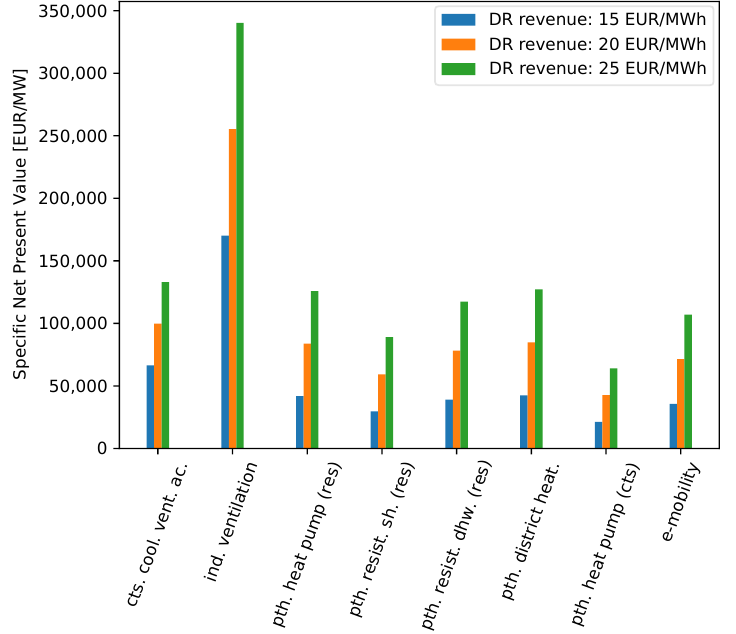
Figure 15. Specific net present values for the DR technologies at a grid node close to the city of Dortmund for the case without investment costs